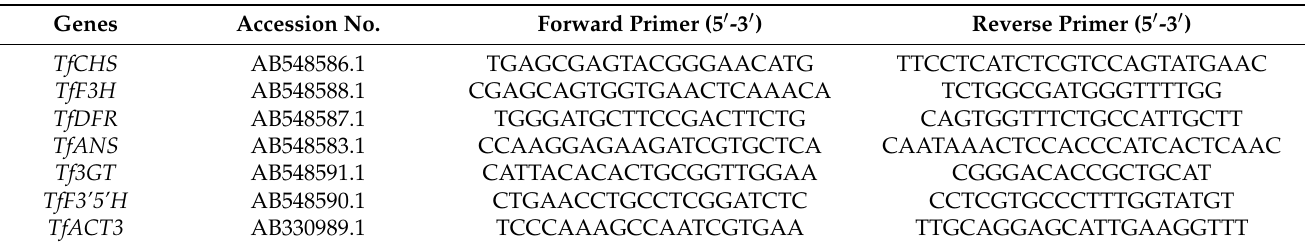
Table 1. List of primer accession number and sequences used in quantitative real-time polymerase chain reaction (qRT-PCR) analysis. Genes Accession